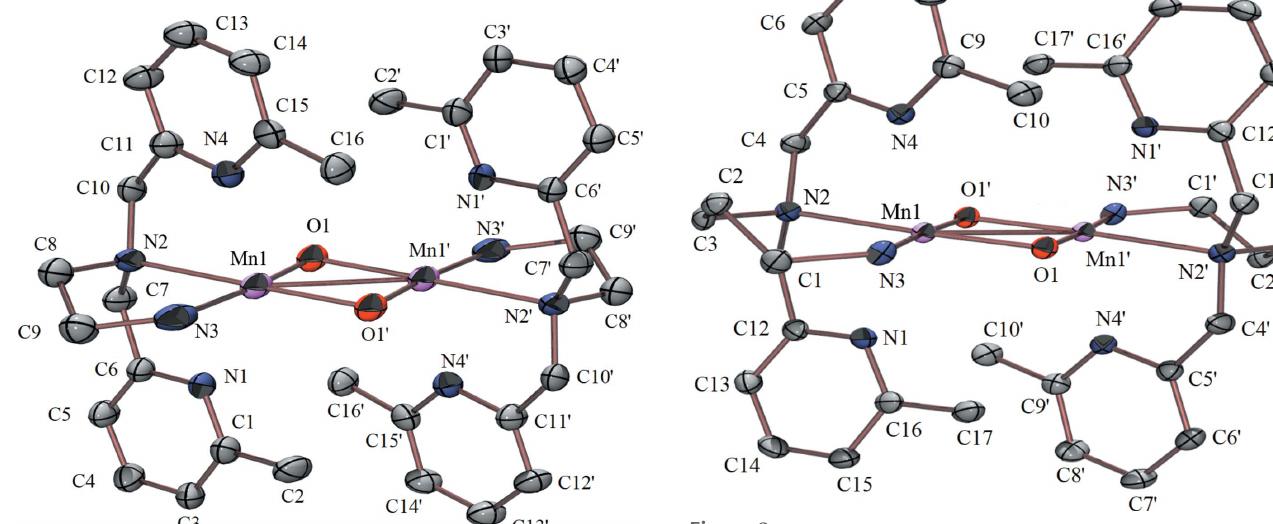
Figure 2 Ellipsoid plot of {[Mn IV (N 4 (6-Me-DPPN))] 2 ( (cid:2) -O) 2 } 2+ ( 2 ) showing the atom-labeling scheme. The anions, solvent, disorder, and hydrogen atoms have been removed for clarity. Displacement ellipsoids are drawn at the 50% probability level. Symmetry code for primed atoms: -x + 1, (cid:3) y + 2, (cid:3) z + 1.